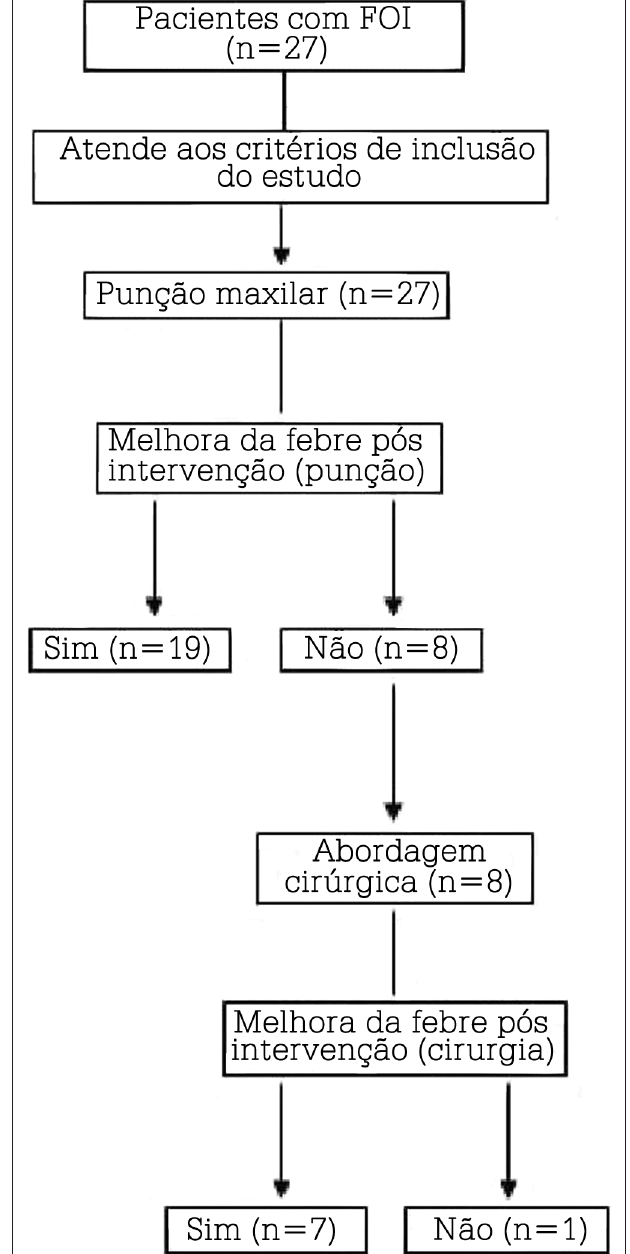
Figura 2. Fluxograma da organização do estudo. n = número de